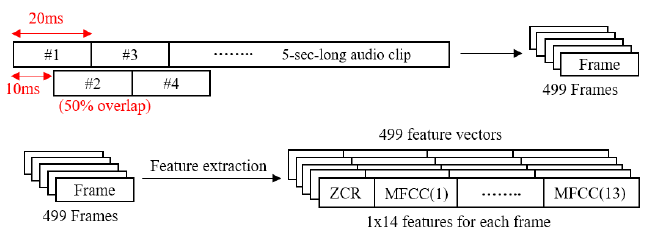
Figure 10. Feature extraction from one audio clip.